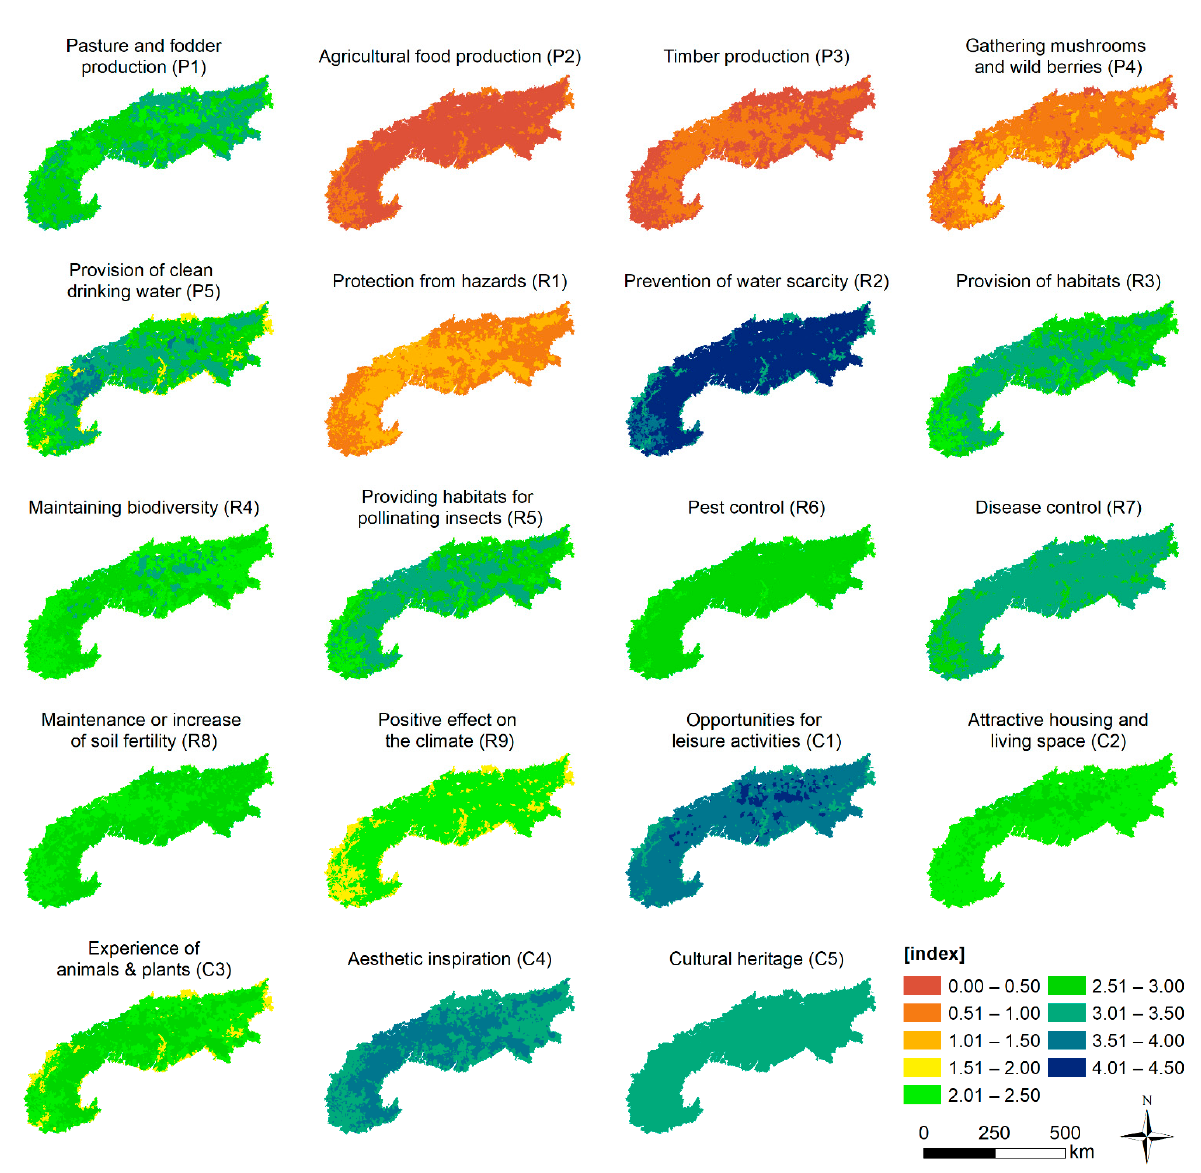
Figure A1. Distribution of ES values in 2018 across the European Alps. Only agricultural LULC types (crop cultivation, permanent culture, fertilized grassland, unfertilized grassland) that were present in 2000 were considered. Thus, these maps illustrate the changes in agricultural land to other LULC types (other agricultural types, abandoned land, forest, settlement areas). Authors own elaboration.